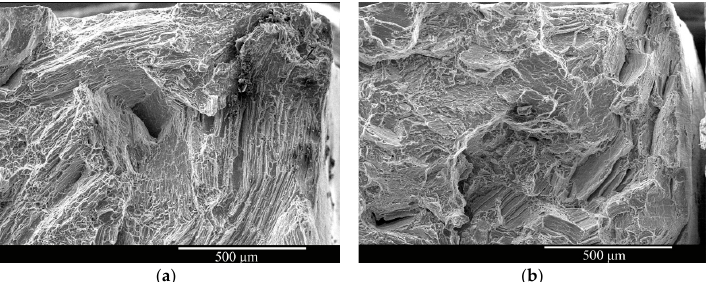
Figure 13. Fracture morphologies of the ( a ) as-cast and ( b ) solid-solution-treated AM50 magnesium alloy samples SSRT tested after pre-immersion in 3.5% NaCl solution for 24 h followed by vacuum dehydrogenation.